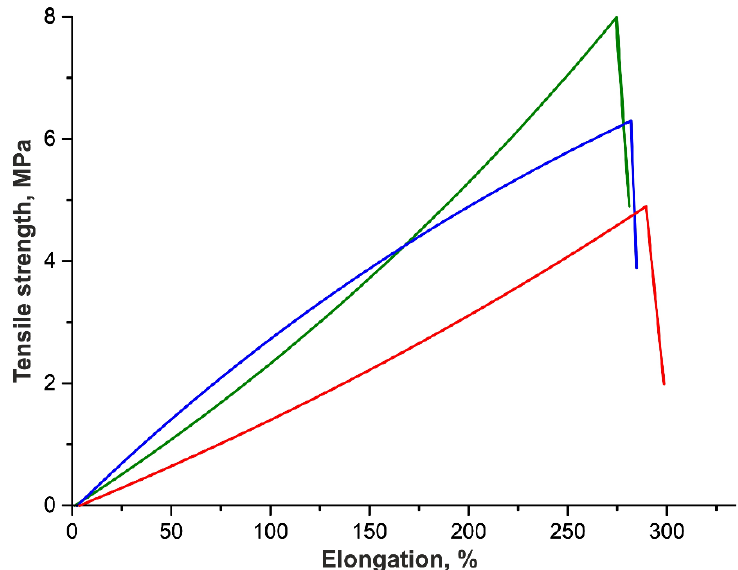
Figure 3. Typical tensile stress diagrams of unimplanted VGs made of Tec-80A (blue line) and the same VGs 3 months (red line) and 6 months (green line) after implantation in rats. Plots are shown as the mean of VG strength measured in three animals.